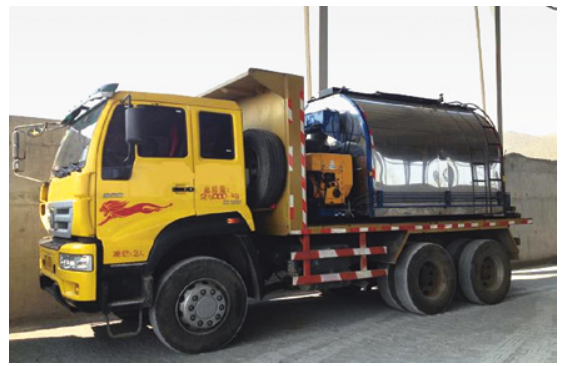
Figure 2. Mixing truck